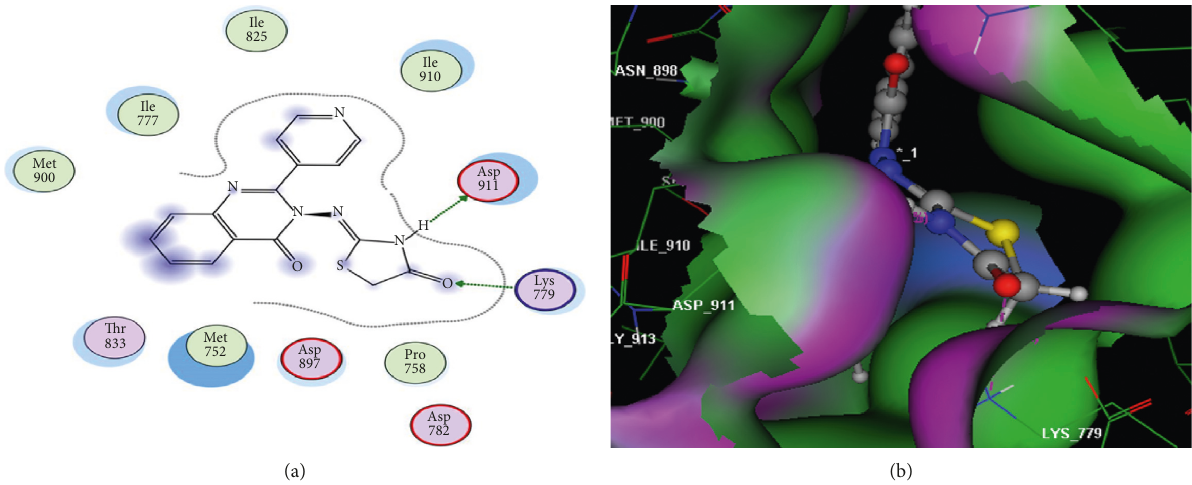
Figure 4: The suggested binding form of derivative 16a docked in the active position of PI3K showing (a) 2D and (b) 3D ligand- receptor interactions, respectively (H bonds are clarified as arrows; C atoms are colored gray; N atoms are colored blue; O atoms are colored